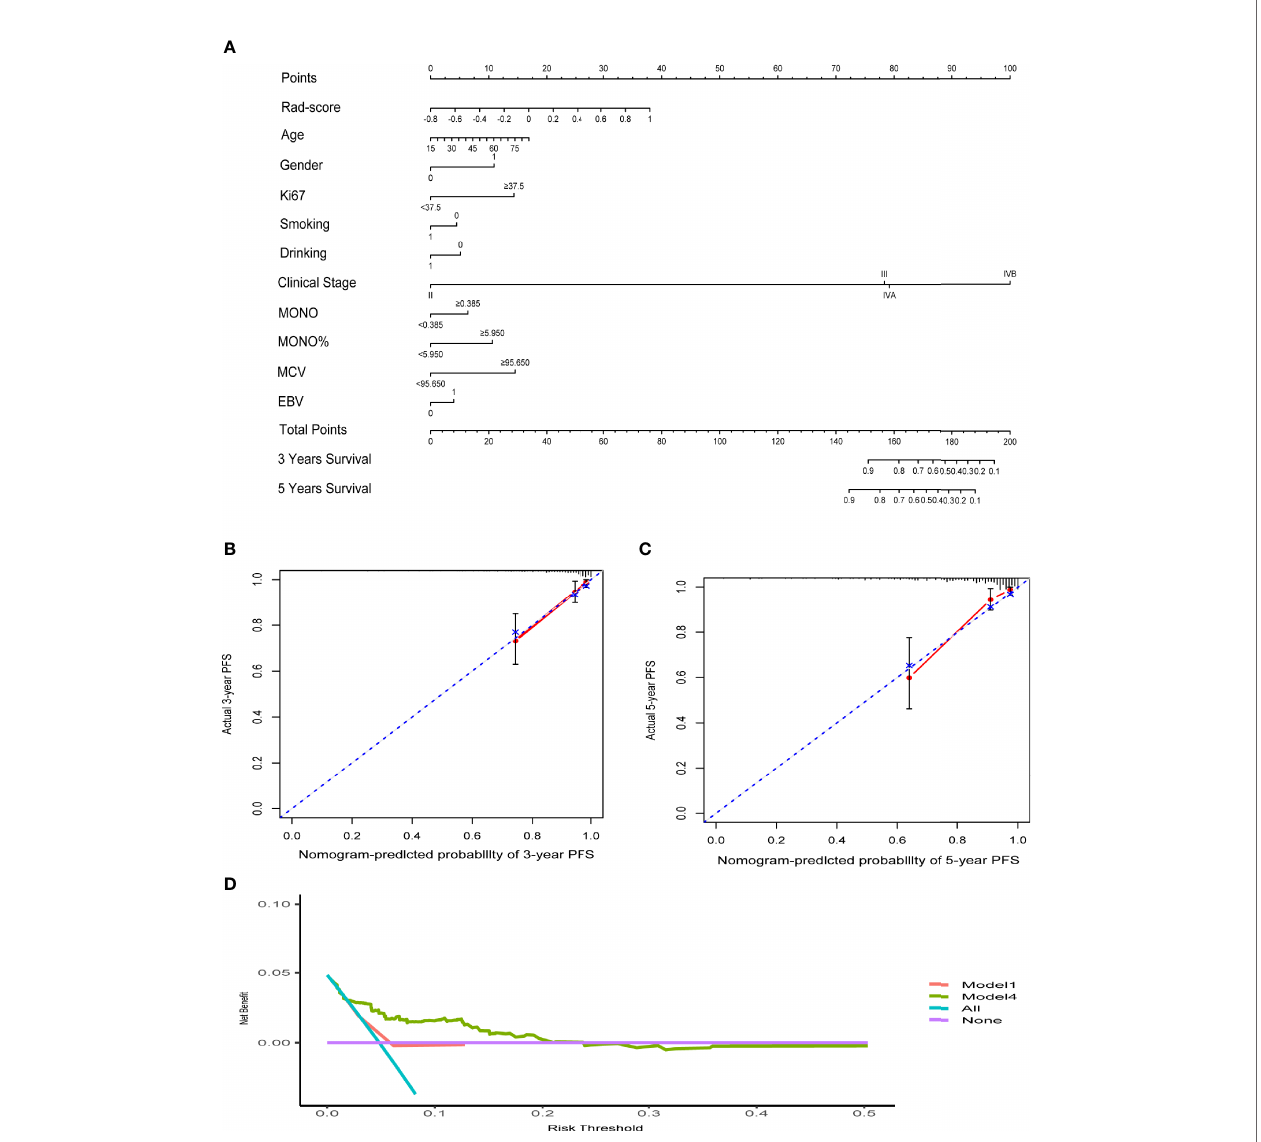
FIGURE 3 | (A) The nomogram of clinical data and rad-score. (B, C) The calibration curves of the nomogram. (D) Decision curve analysis for Model4 and Model1. The y-axis measures the net bene fi t. The red line represents Model 1 (clinical stage). The green line represents Model 4 (clinical data and rad-score). The blue line assumes that all patients progress. The purple line indicates that no progression is assumed in all